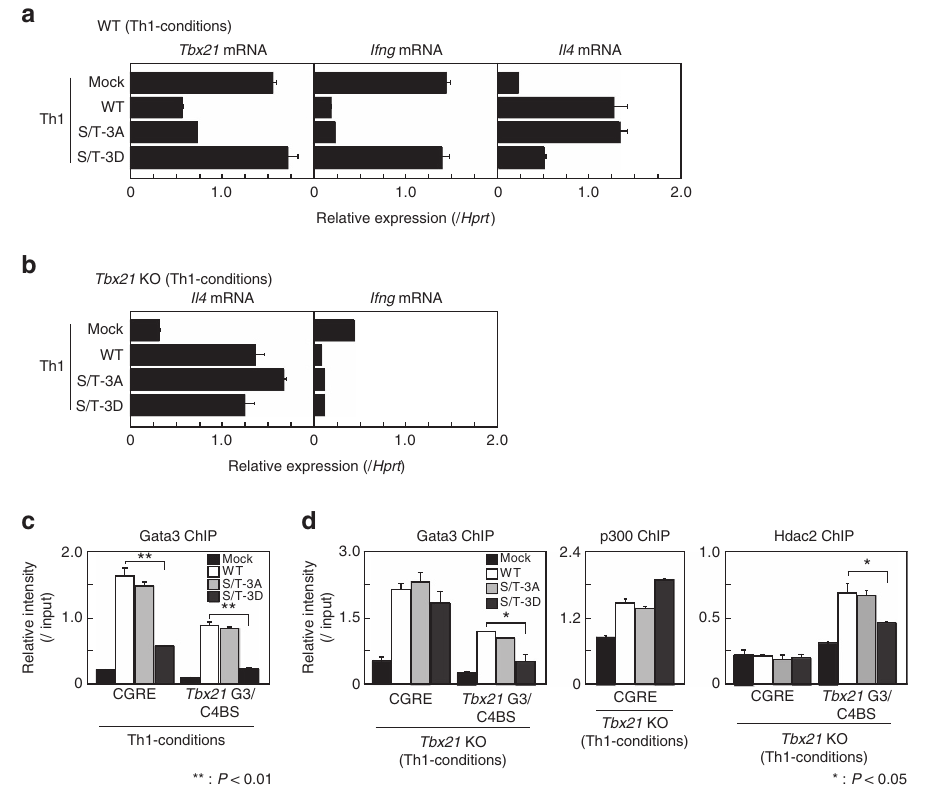
Figure 3 | Phosphorylated Gata3 is incapable of repressing T-bet-dependent Ifng expression. ( a , b ) Naive CD4 T cells from WT ( a ) or Tbx21 -deficient ( b ) mice were stimulated under Th1 conditions and then infected with a retrovirus vector carrying WT or mutant Gata3 (S/T-3A, S/T-3D) cDNA. Three days later, the retrovirus-infected GFP-expressing cells were purified and the levels of mRNA of Tbx21 were measured by RT-qPCR ( a ). For the induction of cytokines, the cells were stimulated with immobilized anti-TCR b mAb for another 4h and then extracted RNA was subjected to RT-qPCR to assess Il4 and Ifng mRNA expression ( a , b ). ( c , d ) Binding of Gata3 WTand mutants (WT, S/T-3A, S/T-3D), p300 and Hdac2 at the CGRE and the Tbx21 G3/C4BS region was determined by ChIP assays followed by qPCR analyses in WT ( c ) or Tbx21 -deficient ( d ) Th1 cells treated as in a , b . The mean values with s.d.’s are shown. ** P o 0.01, * P o 0.05 by Student’s t -test. Four ( a ), three ( b ) and two ( c , d ) independent experiments were performed with similar